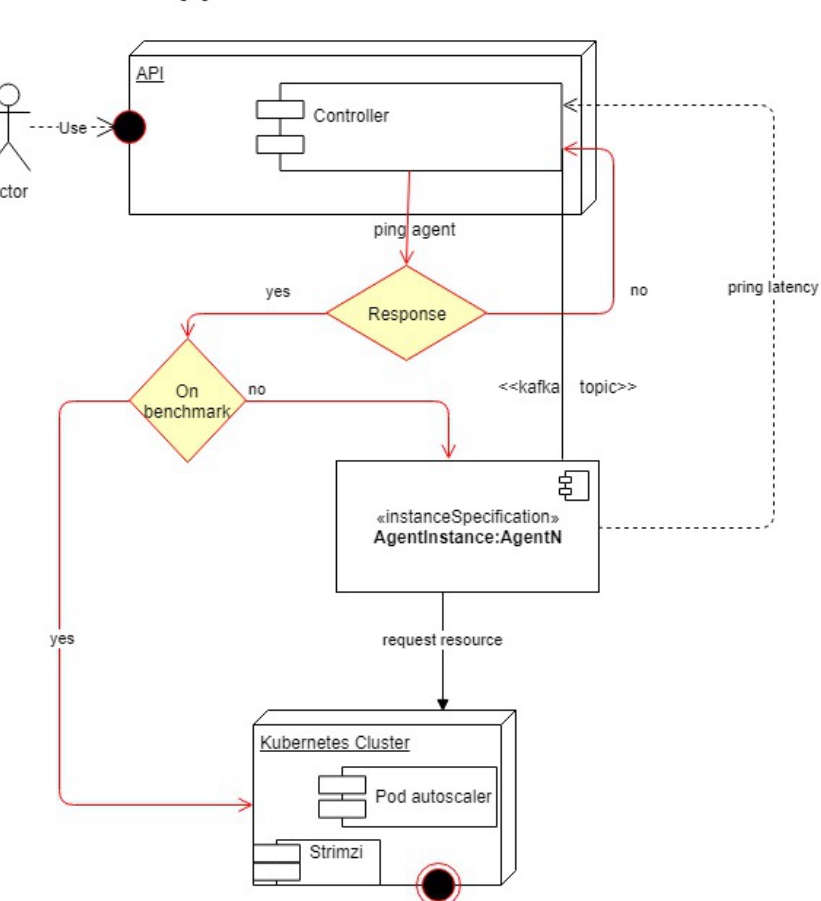
Figure 4. Diagram depicting a complete, high-level, resource request workflow using the API.